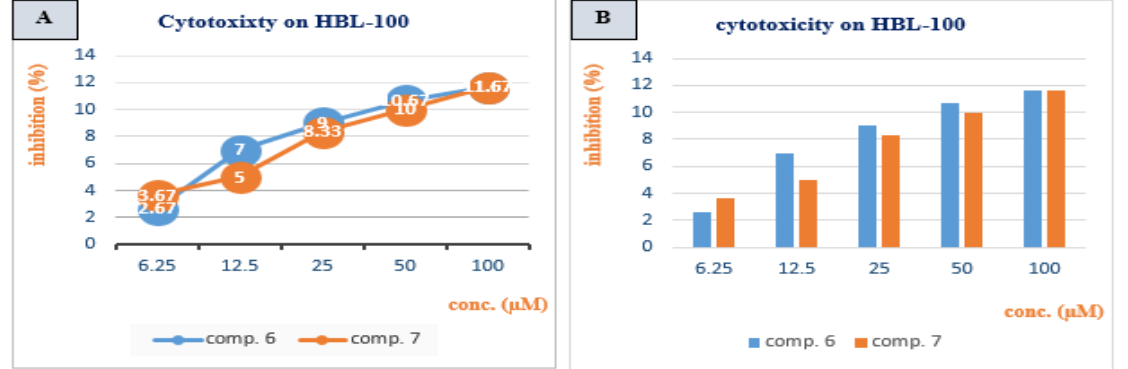
Figure 7. Low cytotoxicity of compounds 6 and 7 on normal breast cells. (A): Concentration-growth inhibition curve. (B): Histogram showing the concentration and growth